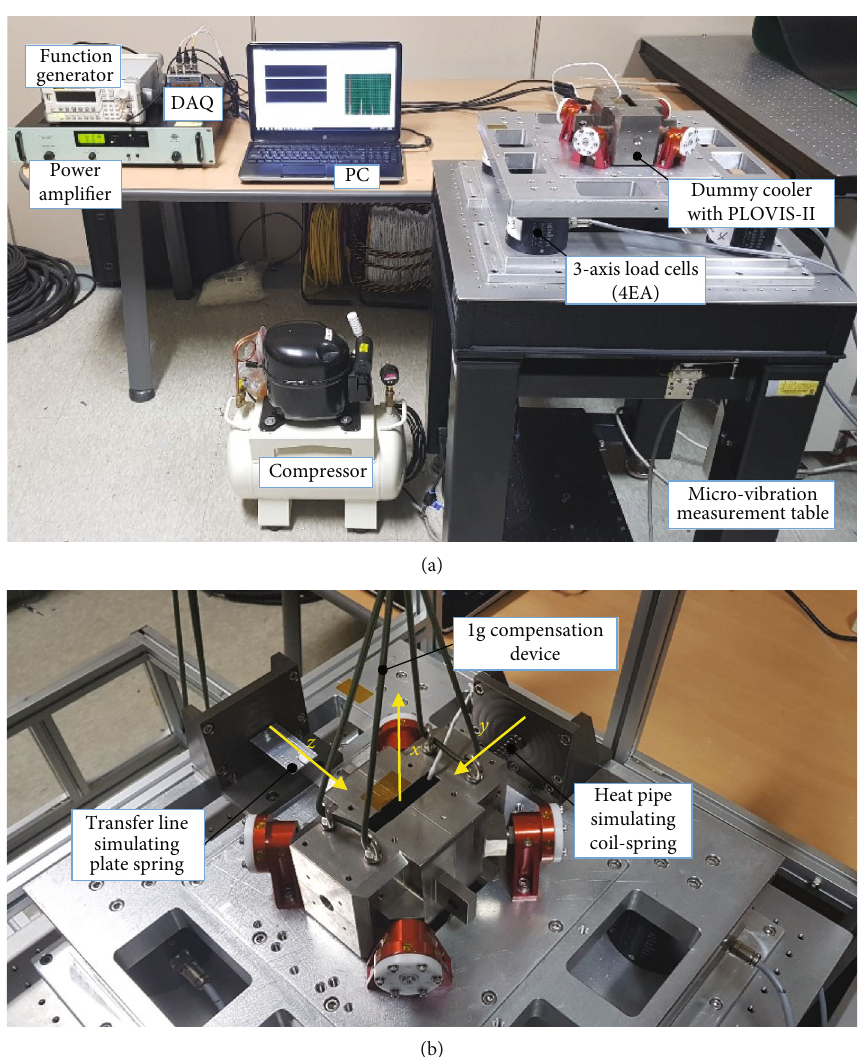
Figure 10: Microvibration measurement test set-up ((a) overall view, (b) enlarged